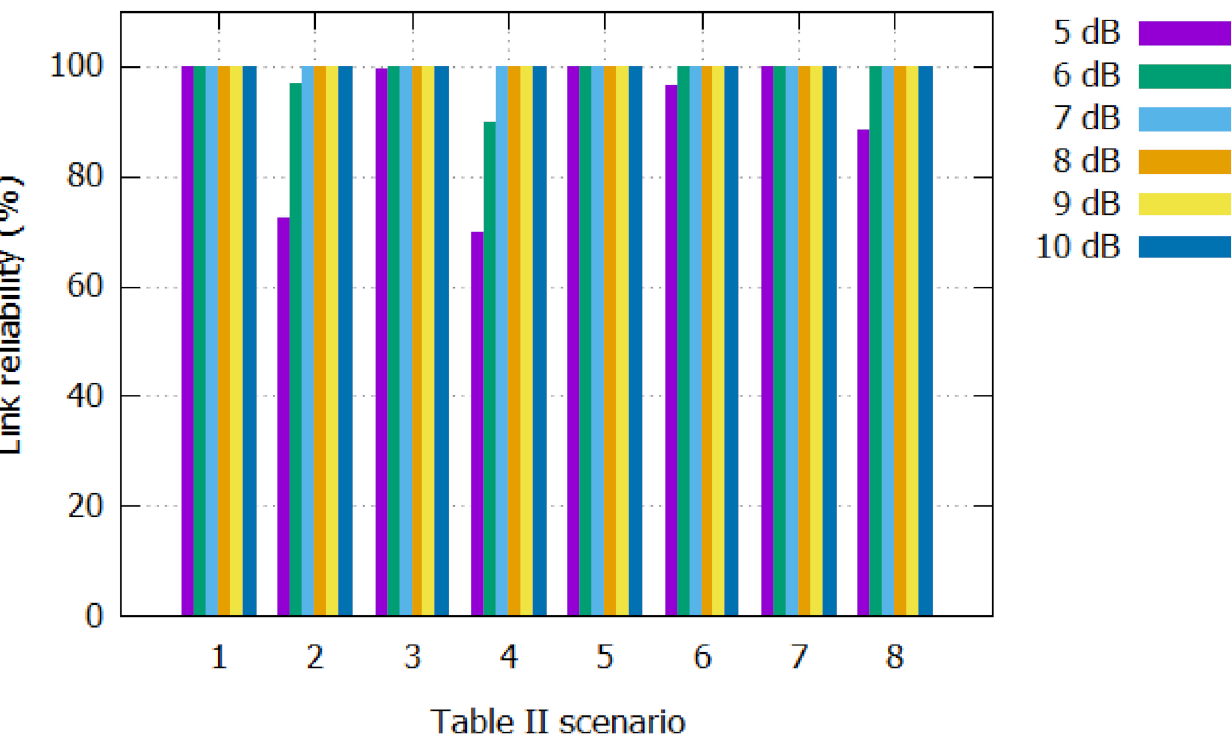
Figure 5. Link Reliability (%) for the different Table 2 scenarios, considering BER for SNR values between 5 and 10 dB, SOVA decoding algorithm and GEMV